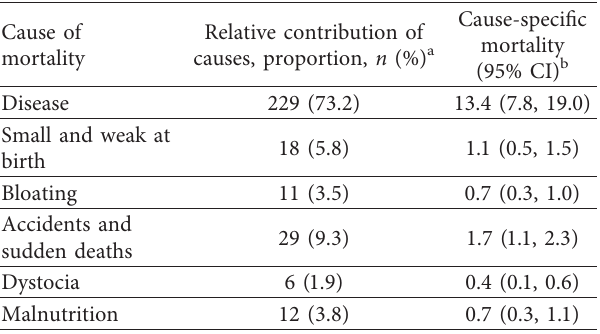
Table 2: Causes of calf mortality in the dairy production system. Cause of